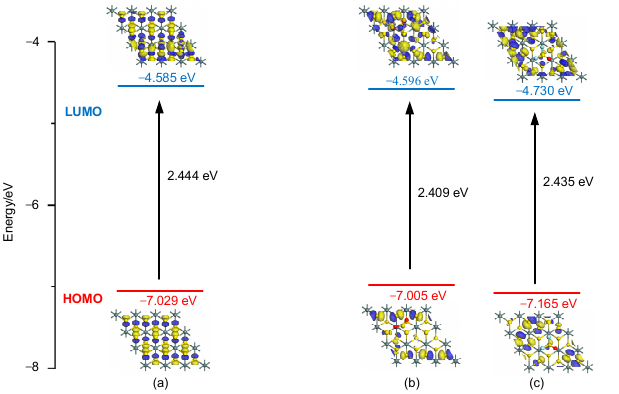
Figure 12. Frontier molecular orbital distribution. ( a ) SnS 2 surface structure; ( b ) the surface structure of SnS 2 adsorbed SO 2; ( c ) the surface structure of SnS 2 adsorbed SOF 2